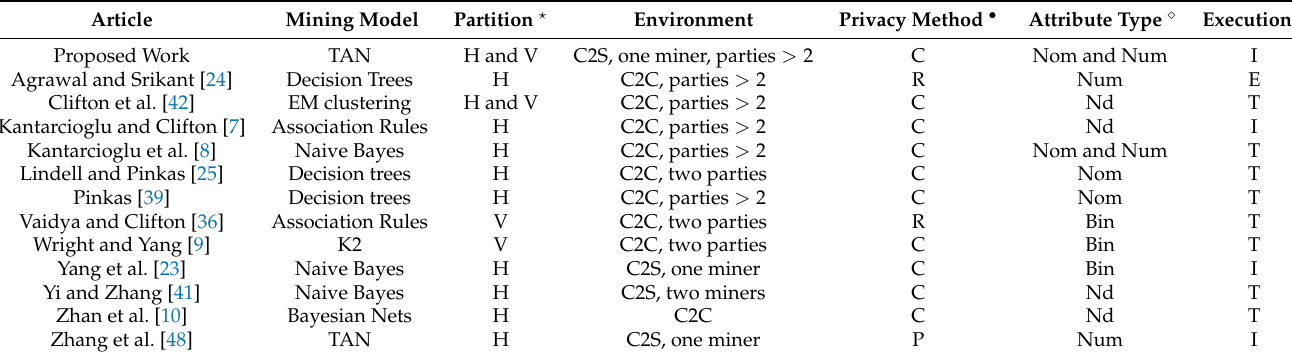
Table 1. Comparison of privacy-preserving data mining (PPDM)